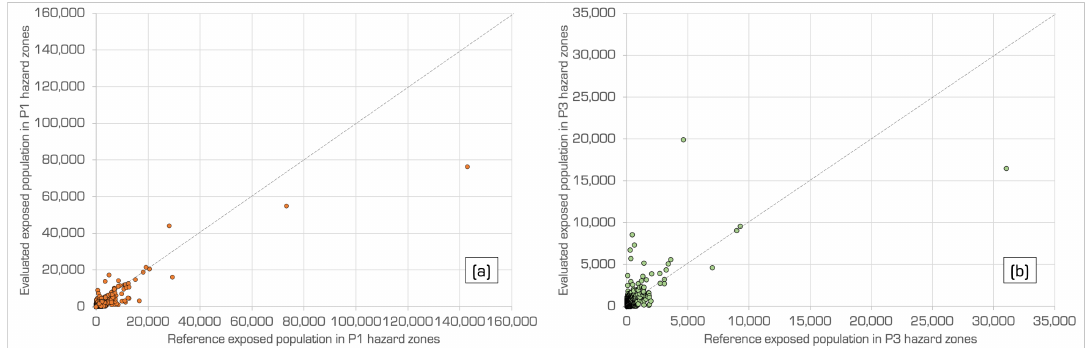
Figure 11. Scatter-plots that show the correlation between estimated and reference exposed population at municipal scale in Lombardy region for P1 ( a ) and P3 ( b ) hazard